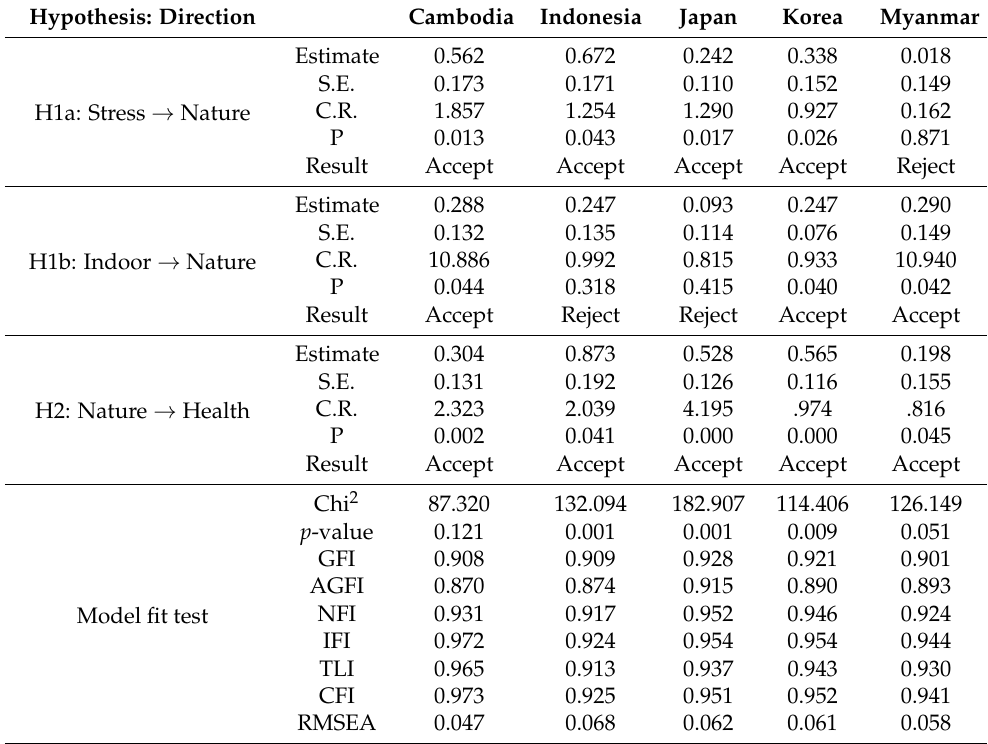
Table 6. Summary of hypotheses results and the model fit